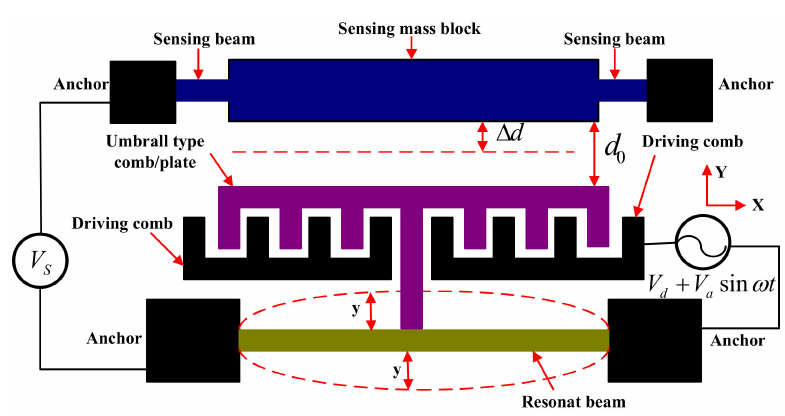
Figure 2. Equivalent diagram of an